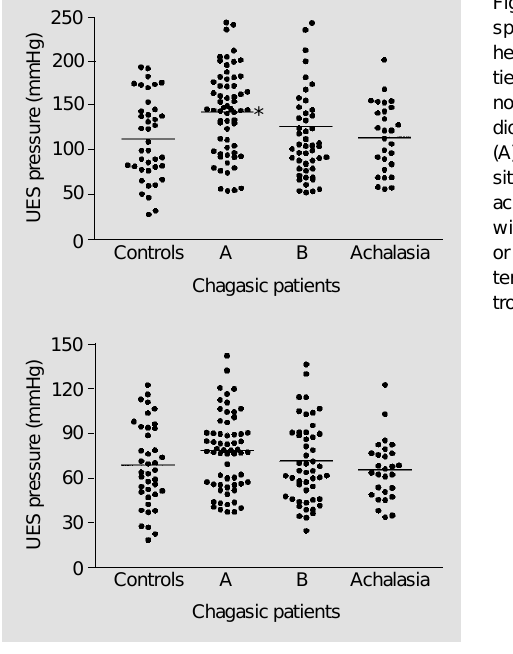
Table 2 - Upper esophageal sphincter pressures (mmHg) of normal volunteers, pa- tients with Chagas’ disease and patients with primary achalasia, measured at the site with the highest pressure and as the average of the four sites where the pressures were